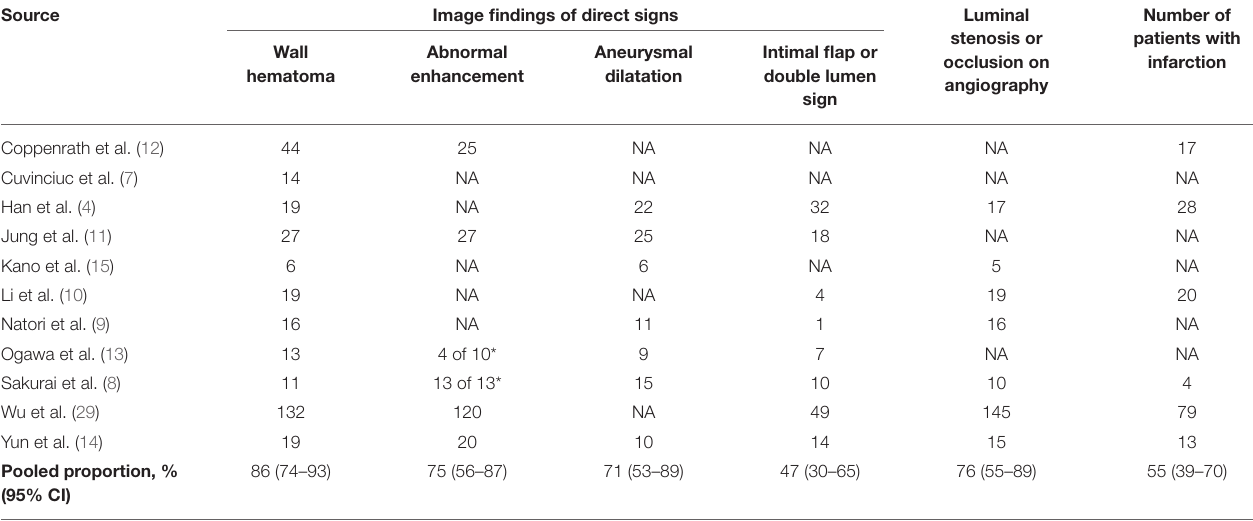
TABLE 4 | Pooled proportion of image findings for arterial dissection on magnetic resonance vessel wall imaging.